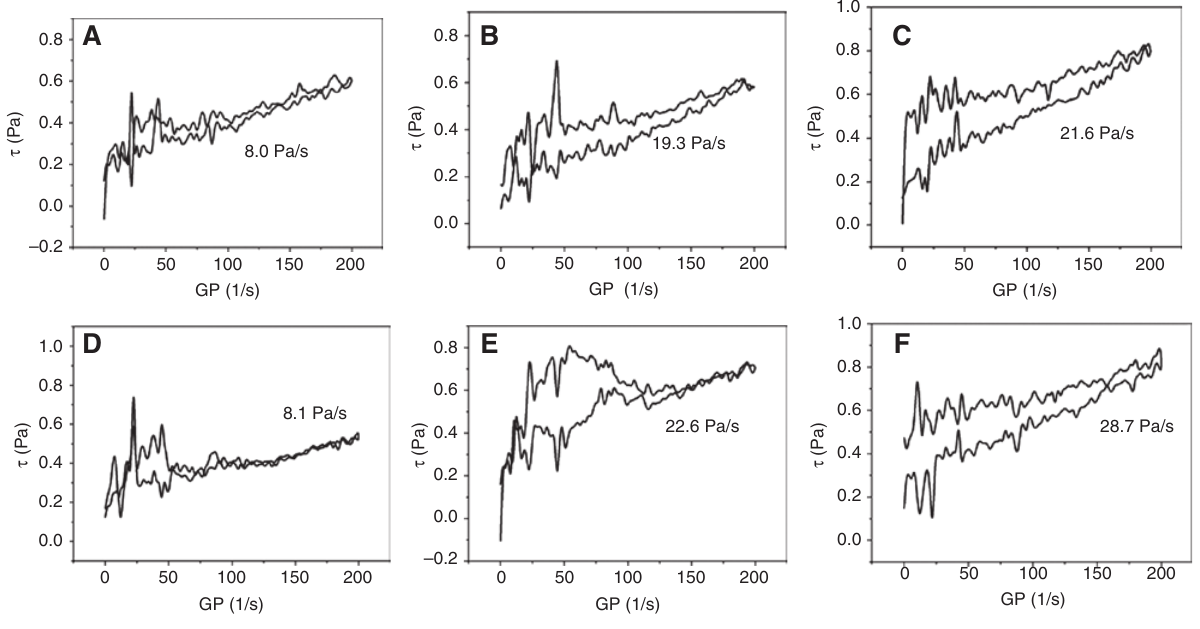
Figure 5: Thixotropic loop diagrams of cationic OMts. (A) OMt (1.0)-D thixotropic loop diagrams. (B) OMt (1.0)-S thixotropic loop diagrams. (C) OMt (1.0)-W thixotropic loop diagrams. (D) OMt (1.5)-D thixotropic loop diagrams. (E) OMt (1.5)-S thixotropic loop diagrams. (F) OMt (1.5)-W thixotropic loop